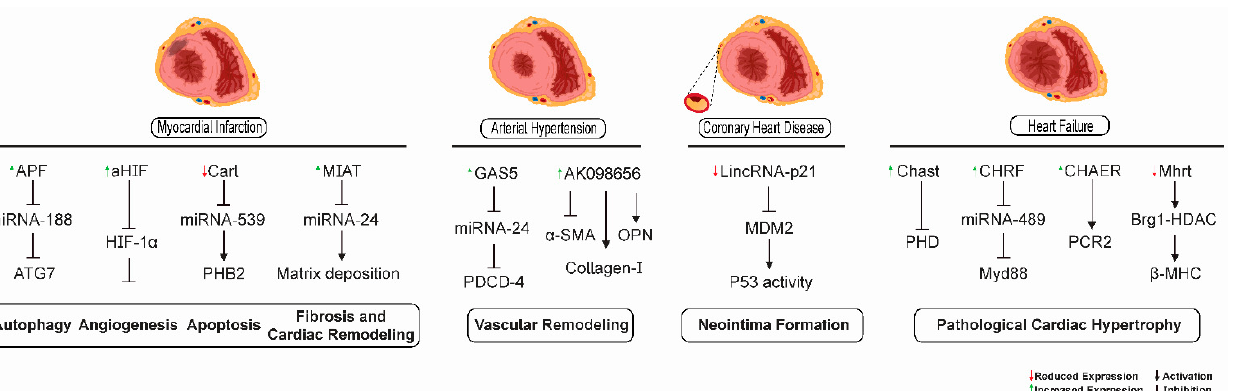
Figure 3. lncRNA-mediated signaling mechanisms as possible therapeutic targets for cardiovascular diseases. lncRNAs have been shown to participate in different pathological processes in the heart and vascular tissues in heart failure, myocardial infarction, coronary heart disease, and arterial hypertension. lncRNAs APF, CARL, aHIF, and MIAT were involved in autophagy, angiogenesis, apoptosis, and cardiac fibrosis processes related to myocardial infarction, respectively. The lncRNAs GAS5 and AK0986656 promoted vascular remodeling in arterial hypertension. The lncRNA lincRNA-p21 was related to neointima formation in coronary heart disease. The lncRNAs MHRT, CHAER, CHRF, and CHAST could serve as promising targets for the retardation of pathological cardiac hypertrophy in heart failure.